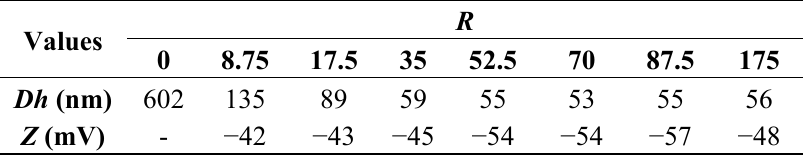
Table 1. Values of hydrodynamic diameter ( Dh ), and ζ -potential ( Z ) measured in water (pH 7.5) at a 5 × 10 − 4 M iron